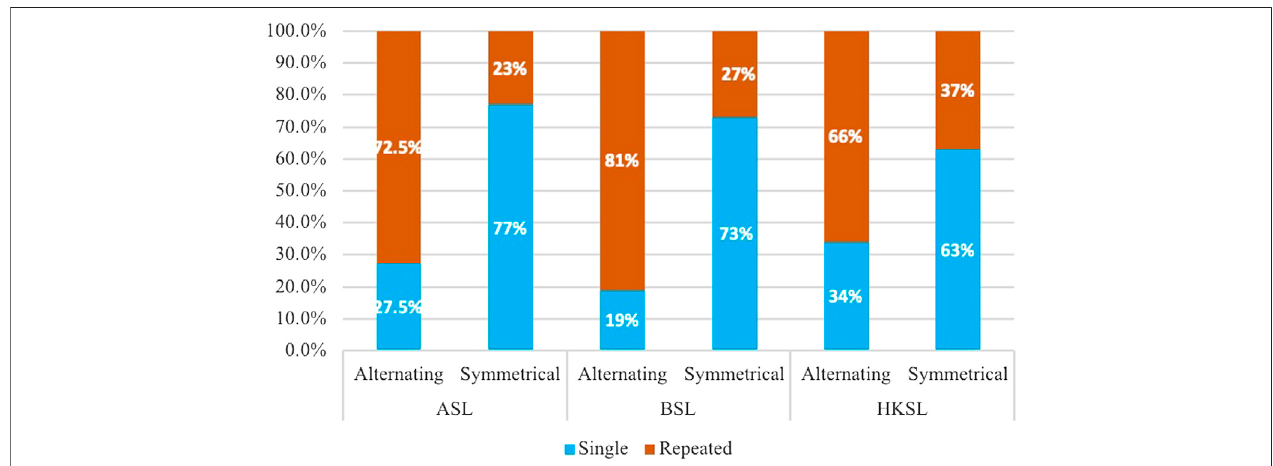
FIGURE 3 | The distribution of repeated and single movements in alternating and symmetrical signs in three sign languages (in percentages).